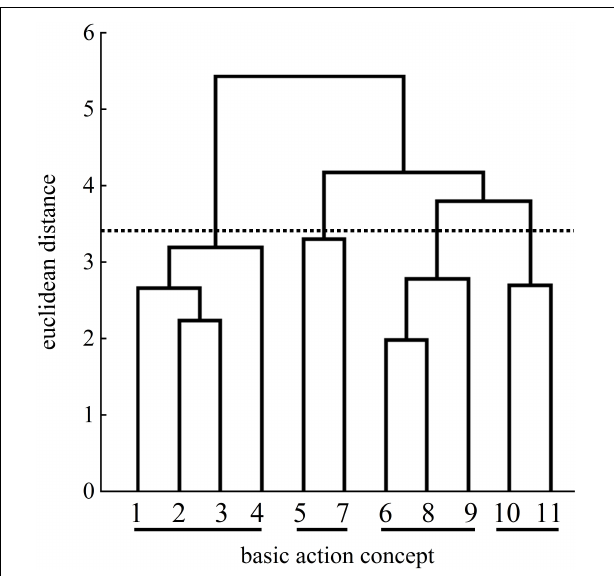
FIGURE 8 | Mean group dendrogram of the explicit group’s ( n = 15) tennis serves on the posttest.